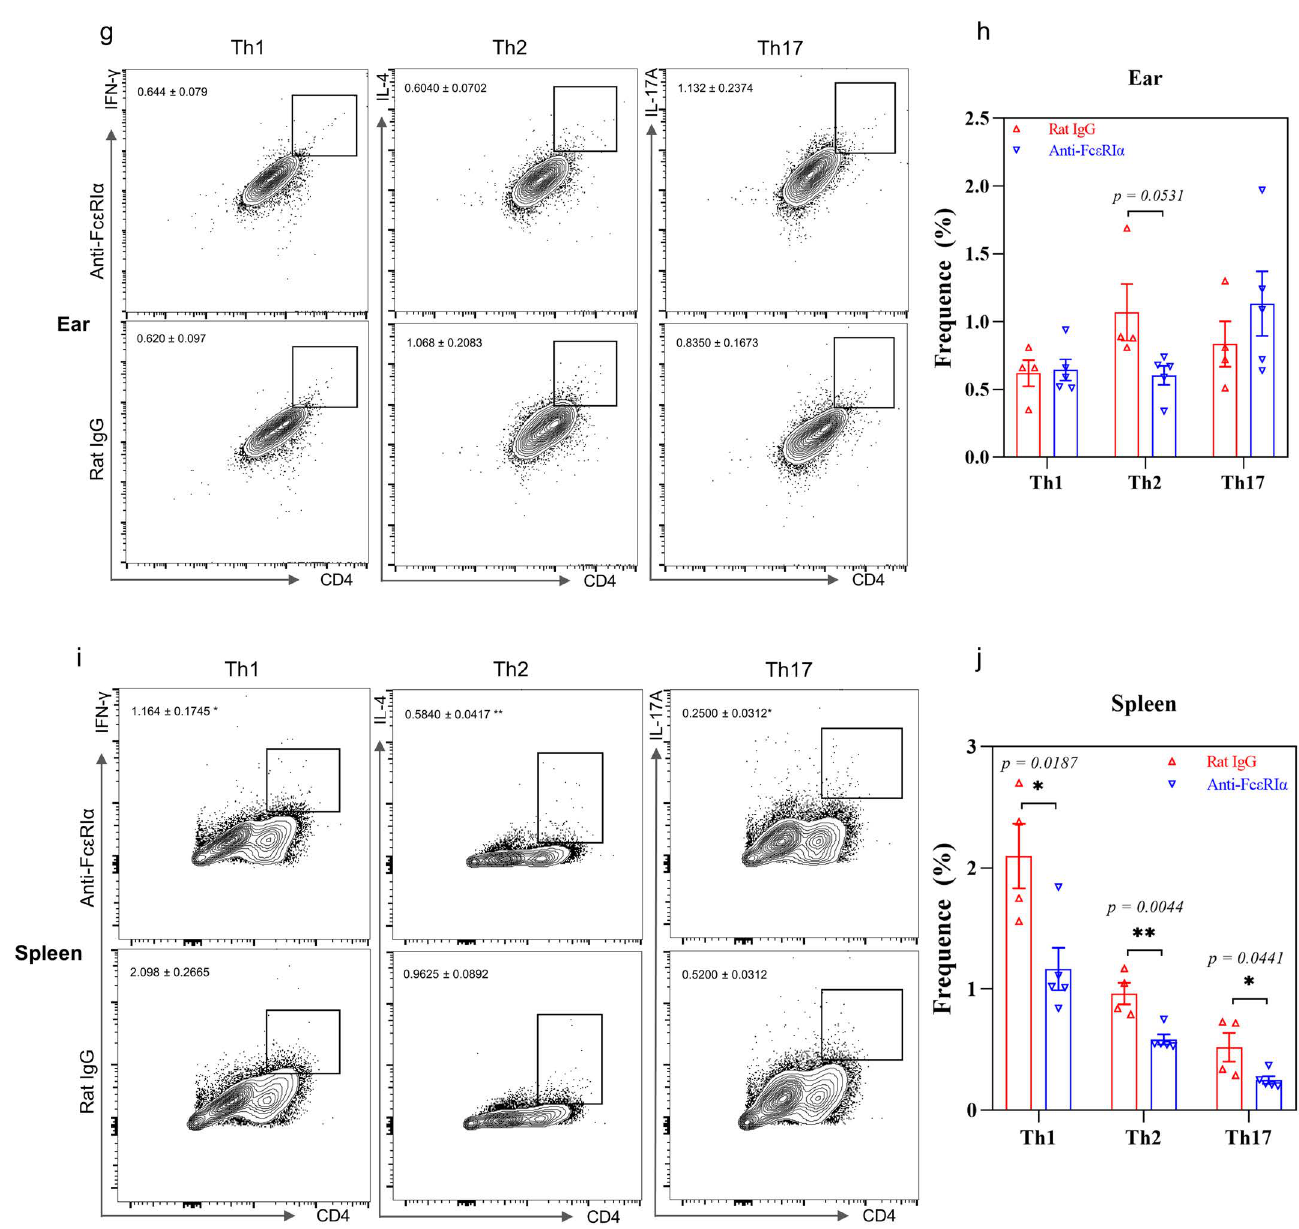
Figure 3. Effects of the depletion of basophils on AD. ( a ) AD murine model schedule; ( b ) ear swelling, skin moisture and scratching times; ( c ) flow cytometry analysis of basophil, eosinophil and mast cell population in the ear tissue; ( d ) quantitative analysis of result in ( c ); ( e ) flow cytometry analysis of basophil, eosinophil and mast cell population in the spleen; ( f ) quantitative analysis of results in ( e ); ( g ) flow cytometry analysis of Th1, Th2 and Th17 cell population in ear tissue; ( h ) quantitative analysis of result in ( g ); ( i ) flow cytometry analysis of Th1, Th2 and Th17 cell population in the spleen; ( j ) quantitative analysis of result in ( i ). Bar charts are shown as mean ± SEM of n = 4 or 5. * p < 0.05 and ** p < 0.01 when compared between the